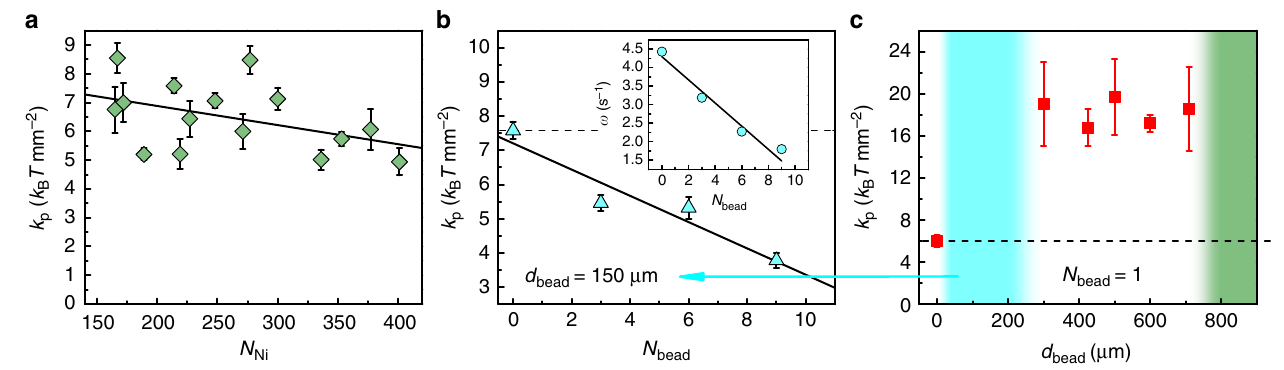
Fig. 3 Potential stiffness manipulation with passive scatterers. a Trapping potential stiffness as a function of number of magnetic rollers comprising the vortex N Ni . The number of rollers has a weak in fl uence on the trapping potential. Black solid line is a linear fi t. B 0 = 5.78 mT, f B = 40 Hz. b Effect of small scatterers ( d bead = 150 ± 9 μ m) on the vortex trapping potential k p (blue triangles, dashed line marks the value for a pristine vortex). Vortex angular speed ω (inset) decreases with the scatterers number. Black solid lines are linear fi ts. B intermediate bead sizes. Three-fold increase in stiffness of the trapping potential k p for intermediate sized scatterers (red squares, dashed line marks the value for a pristine vortex). The blue region indicates the system response as in b and the green area shows the bead sizes, where even a single scatterer destroys the vortex state. B 0 = 7.54 mT, f B = 43 Hz, N Ni = 271. Error bars in all panels are the standard deviation of the measurements